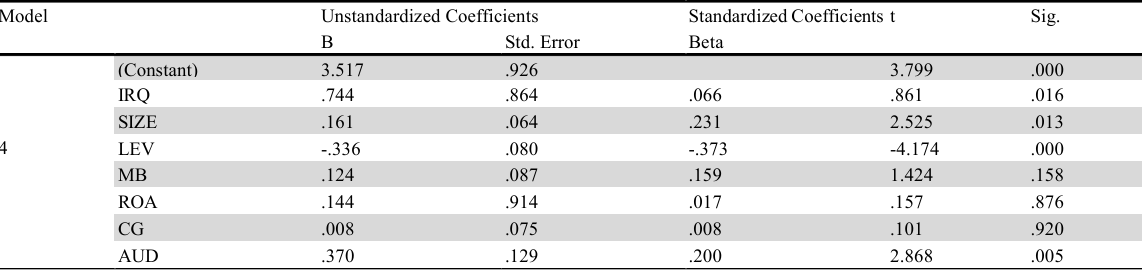
The results of the regression analysis between DQIBR and Firm Value Model Unstandardized Coefficients Standardized Coefficients t Sig. B Std. Error